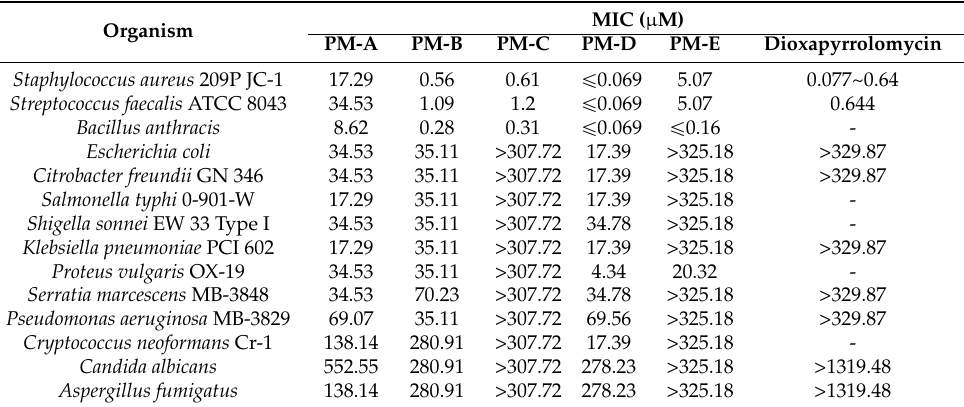
Table 2. Antibacterial activities of natural pyrrolomycins.